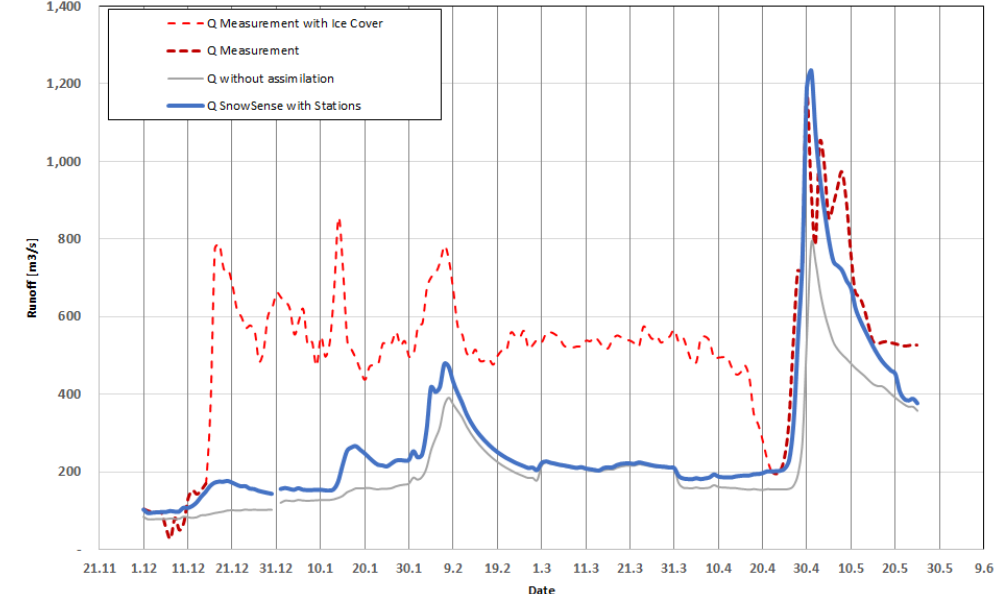
Figure 10. Daily run-off results from PROMET without (grey), with assimilation (blue) of stations and EO against the values (dashed red) measured at Charlie Edwards Point (catchment: 8850 km 2 ) for the winter season 2017/18. Due to river ice for the period mid-December to late April, the measurements have been separated into measurements with ice cover (normal dashed line) and without (bold dashed